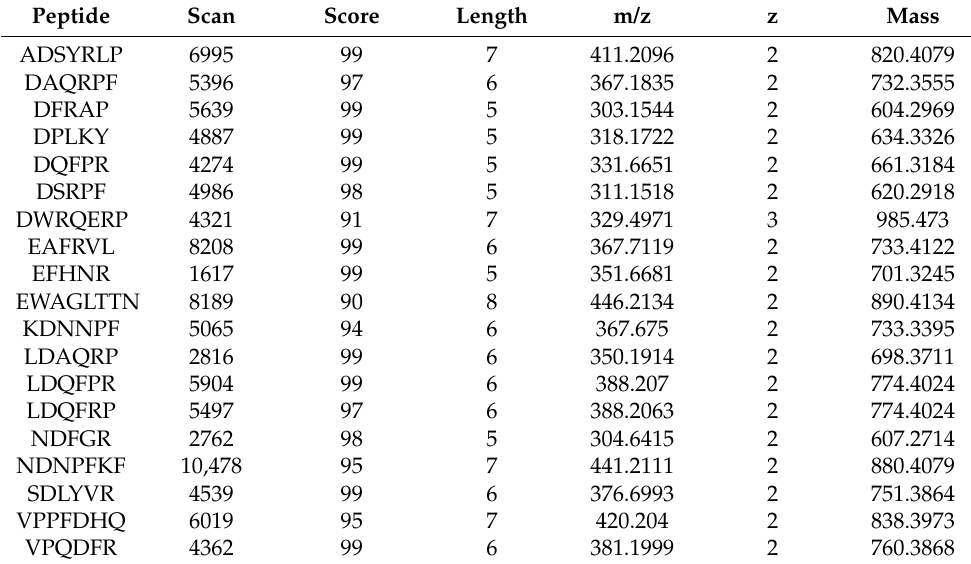
Table 4. Obtained peptide information.